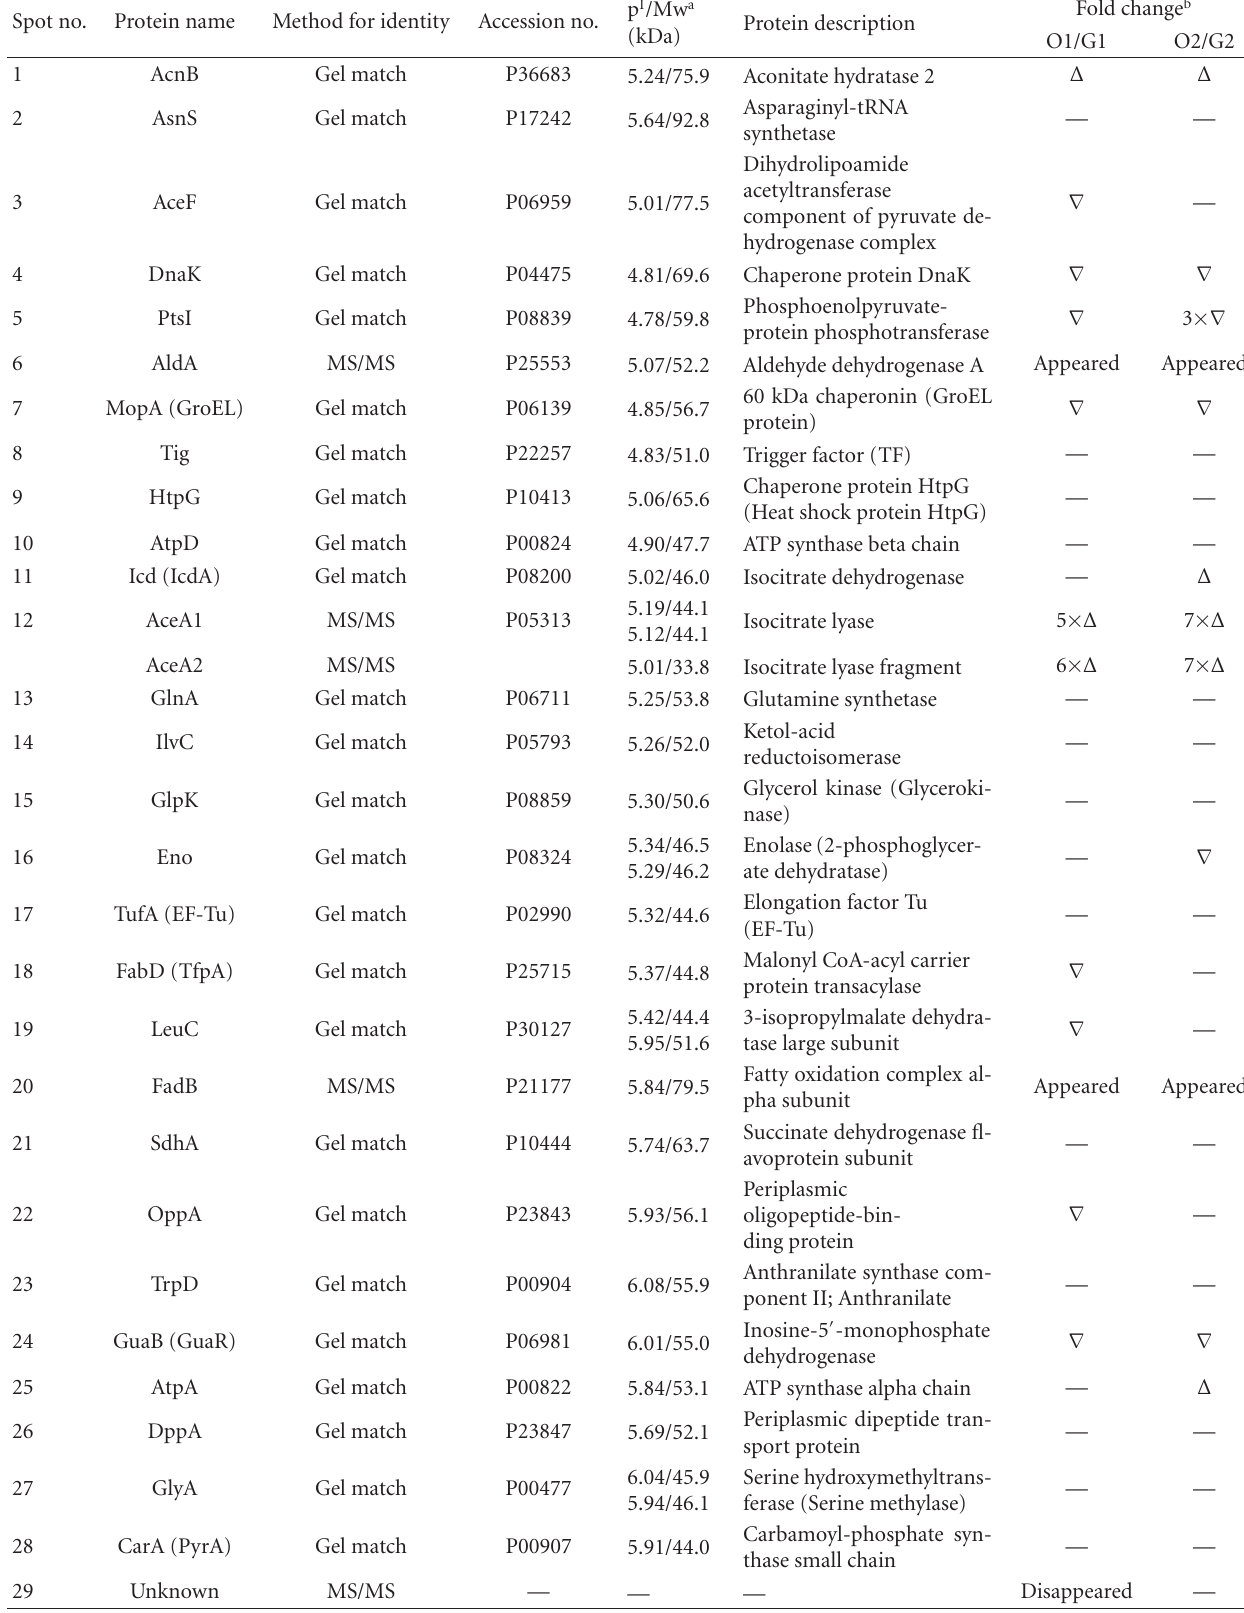
Table 3: Proteins identified from